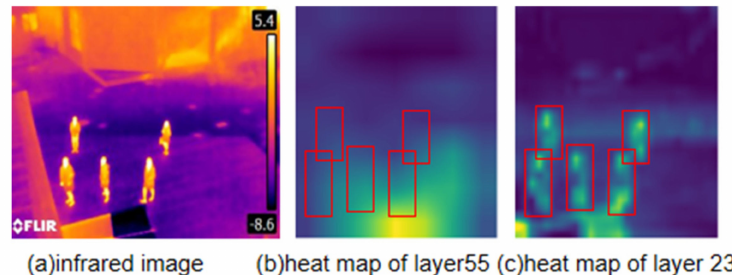
Figure 3. Heat map analysis. Figure ( a ) shows the infrared image used for visualization, Figure ( b ) shows the heat map obtained from network layer 55, and Figure ( c ) shows the heat map visualized from network layer 23, with the area beyond the pedestrian in the figure as the background area. The red boxes are manually labelled true value